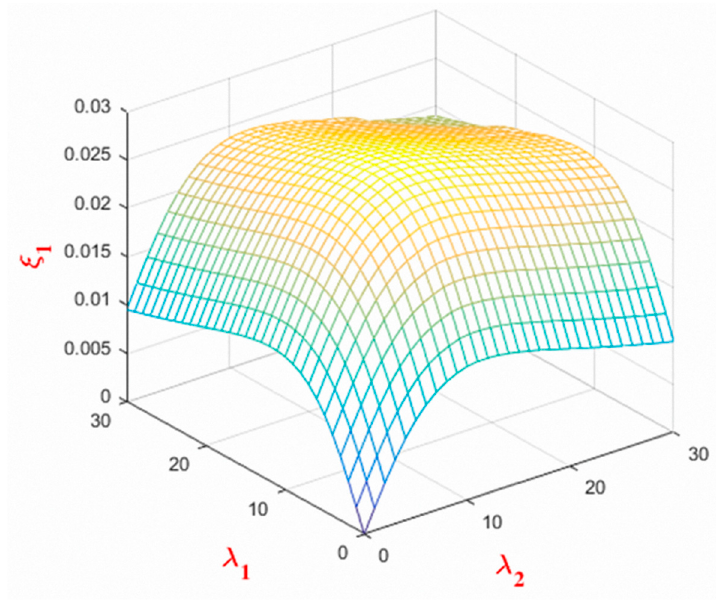
Figure 11. Loss factors optimization for two HDR dampers.